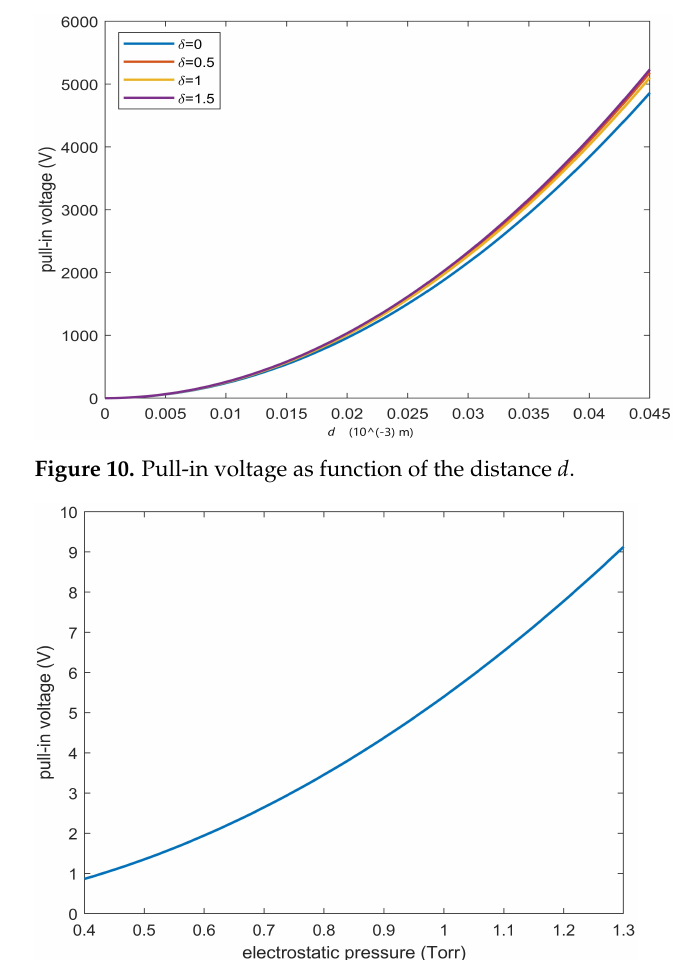
Figure 11. V pull − in versus ( p el ) fringing